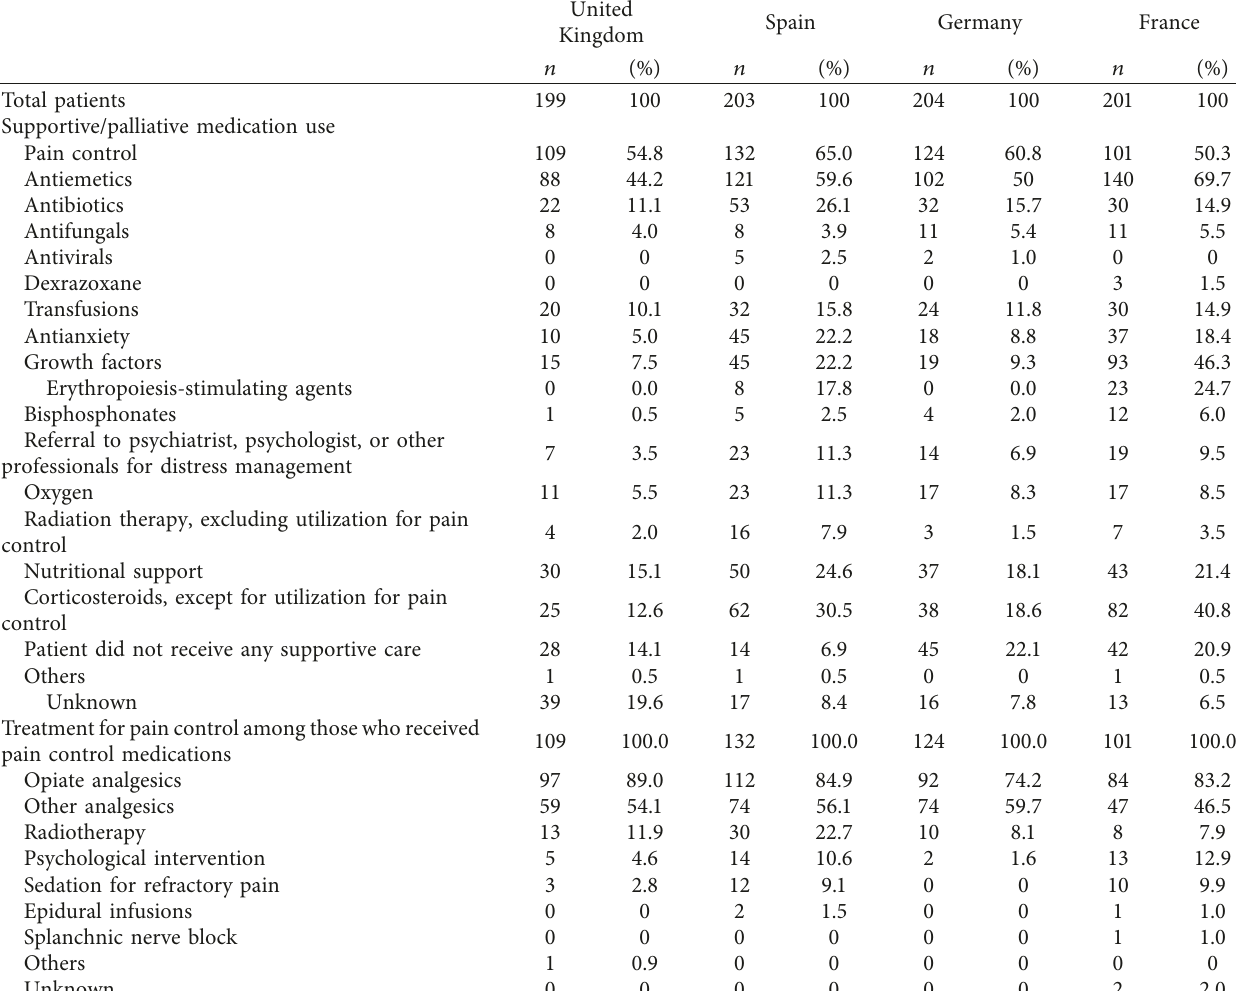
Table 3: Use of supportive/palliative medications from time of advanced STS diagnosis to